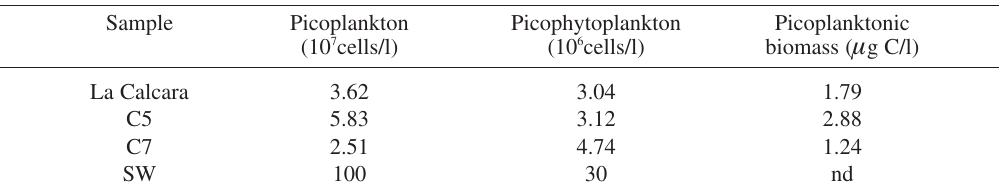
Table IV. Picoplankton and Picophytoplankton abundances and calculated picoplanktonic biomasses in ther- mal waters sampled at the sea-bottom of Panarea. The local seawater (SW) is reported for comparison. nd = not